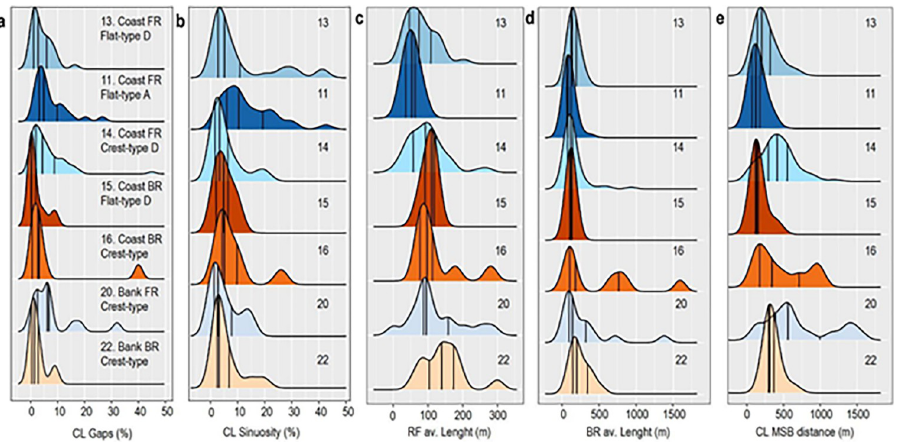
Fig 4. Kernel density estimates of morphometric data described in Table 3 with quartiles. Panels a and b show density curves corresponding to crestline sinuosity and persistence (% gaps) by reef subtype (in percentages). Panels c, d and e show density curves in reef-front and back-reef areas (av. length) and reef-front slope (Crestline-MSB distance). Of those with consistent morphologies (11, 13, 15, 22) all three flat types (11, 13, 15) show back-reef areas with the same normal distribution, central tendency and narrow dispersion, and steep reef-front